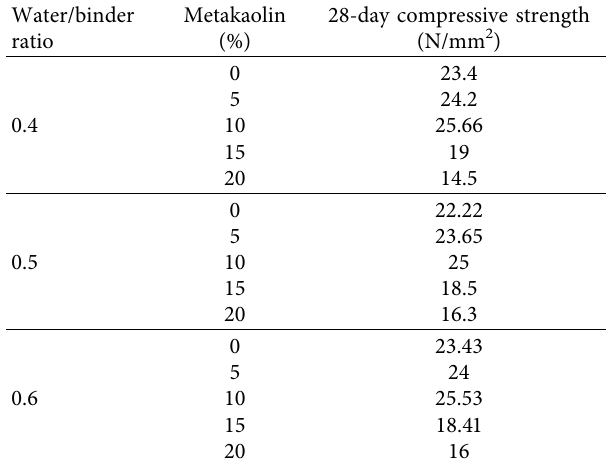
Figure 3: Gene expression tree of the model. (a) Sub-ET 1. (b) Sub-ET 2. (c) Sub-ET 3. Table 7: Compressive strength of metakaolin concrete for grade M20.